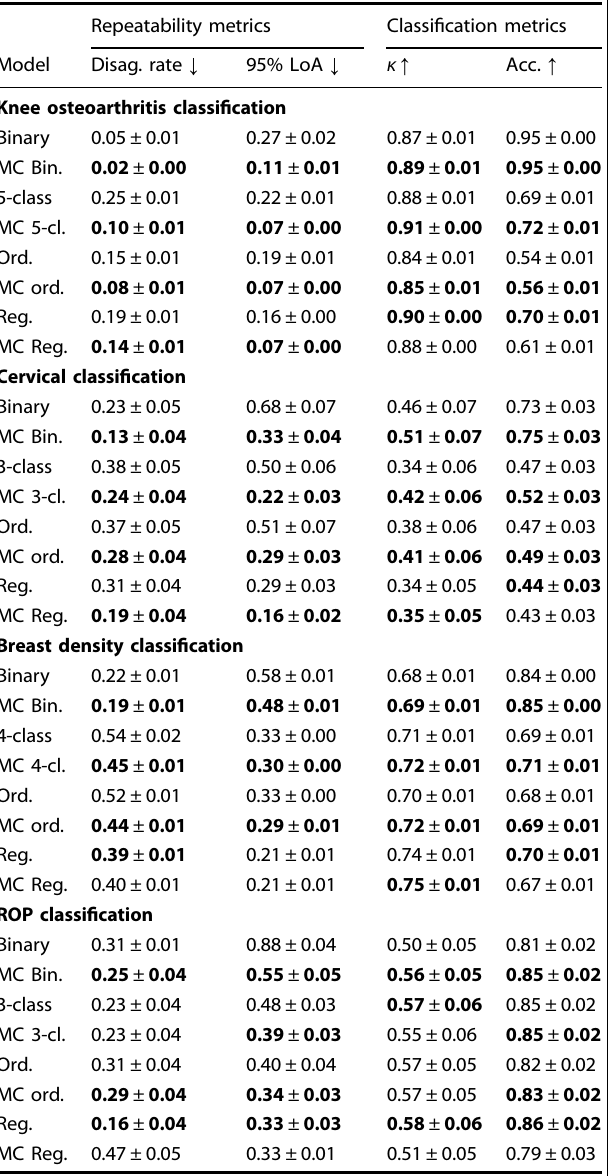
Table 1. Model performance overview (MEAN ± 95% CI) a .